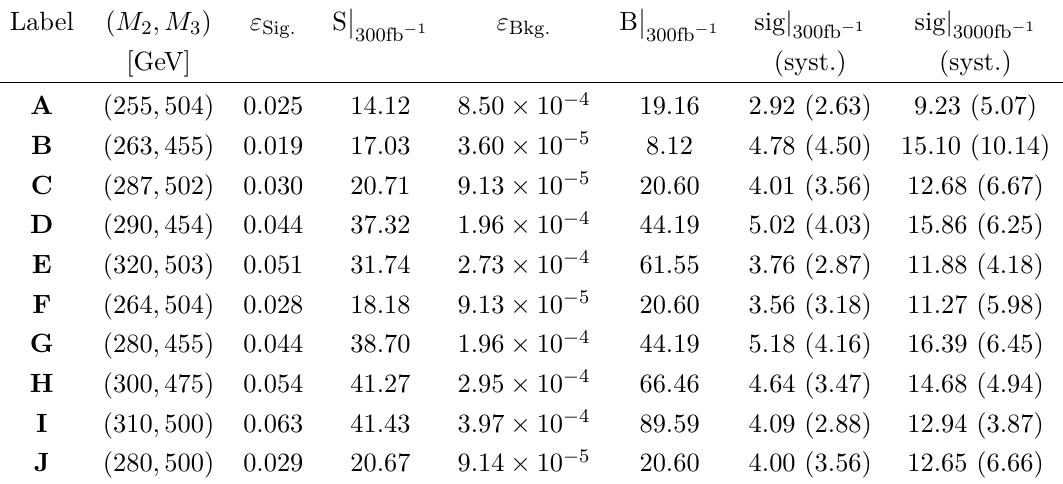
Table 4 . The resulting selection efficiencies, ε Sig . and ε Bkg . , number of events, S and B for the signal and background, respectively, and statistical significances for the sets of cuts presented in table 3. A b -tagging efficiency of 0 . 7 has been assumed. The number of signal and background events are provided at an integrated luminosity of 300 fb − 1 . Results for 3000 fb − 1 are obtained via simple extrapolation. The significance is given at both values of the integrated luminosity excluding (including) systematic errors in the background according to eq. (5.1) (or eq. (5.2) with σ b = 0 . 1 × B